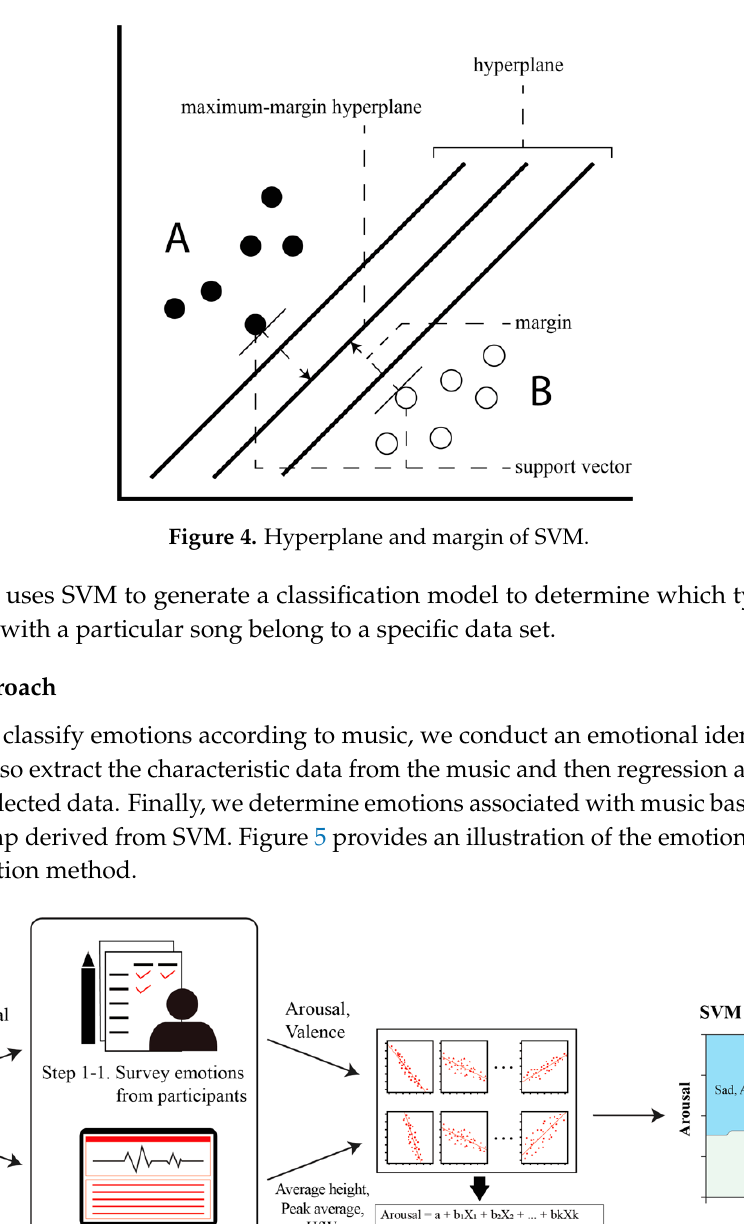
Figure 5. Overall approach. The approach consists of three steps: (1) emotional and music data are collected from participants and songs, (2) regression analysis is applied to identify the relationship between emotional data and music data and (3) a classification algorithm is applied to determine how the emotional data correlated with the music data are related to the actual emotions.